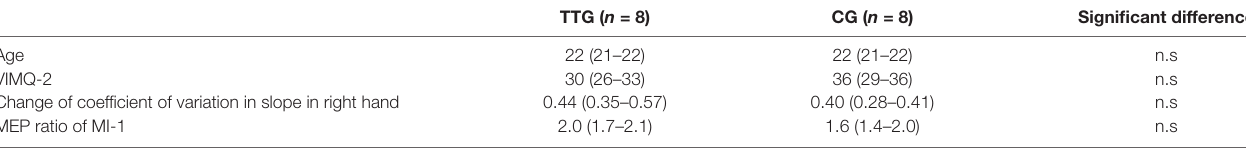
TABLE 1 | Comparisons of baseline data.